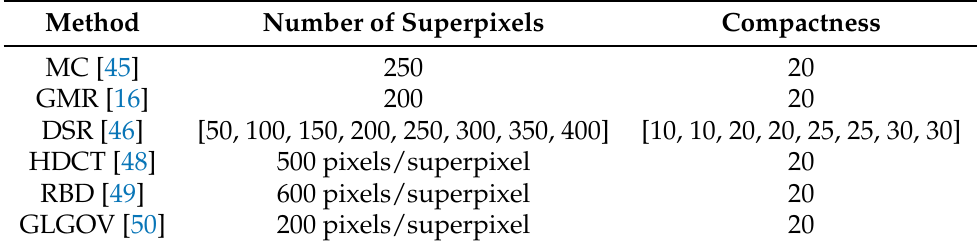
Table 1. Six methods used in the experiment and parameters for SLIC.